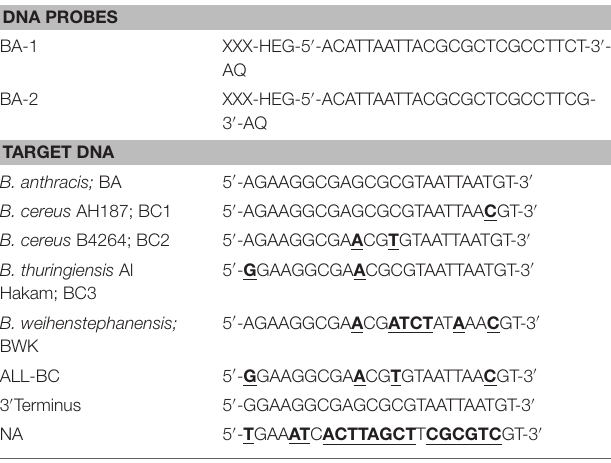
TABLE 1 | Sequences of anthraquinone modified DNA probes and target DNA for the rpo B gene target of Bacillus species. DNA